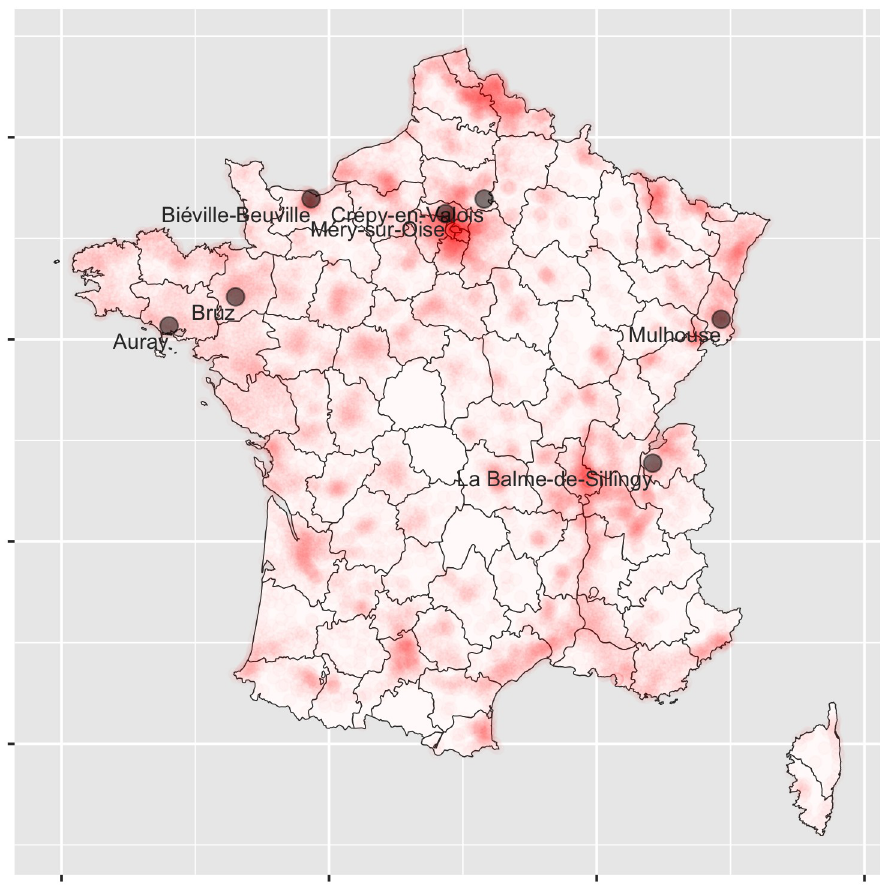
Fig 2. Revealed COVID-19 clusters in time of election and number of cases released afterwards. The map is created in R (3.5.3) [17] using package ggplot2